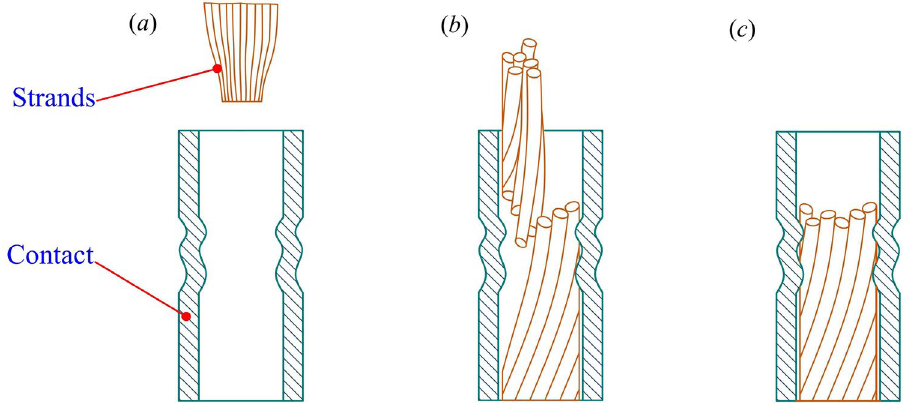
Figure 8. Types of failure in the tensile test of crimped samples. ( a ) Strands slide out of the contact crimping barrel. ( b ) Strands are partially broken at the crimping point, and some of the wire cores slide out of the contact crimping barrel. ( c ) Strands are completely broken at the crimping point.